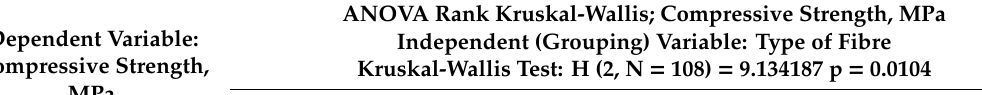
Table 10. Results of the Kruskal-Wallis ANOVA rank test of compressive strength related to the type of fibres.